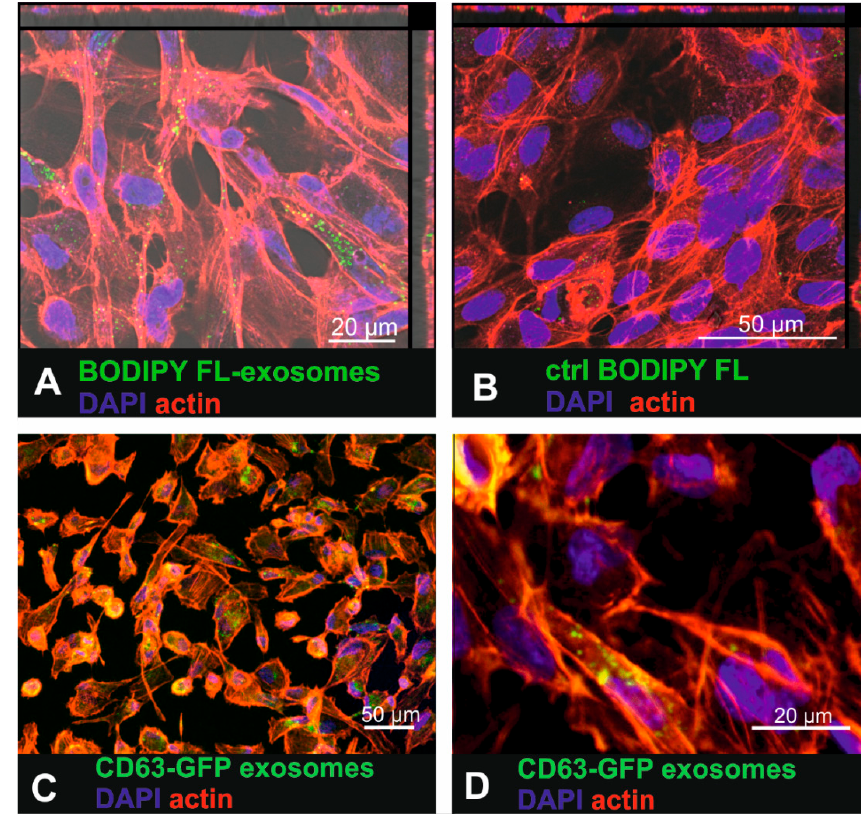
Figure 2. Uptake of urinary BODIPY-labelled small EVs and CD63-GFP tagged fibroblast-derived small EVs in ARPE19 cells. ( A ) Incubation of the ARPE-19 cells with BODIPY-labelled small EVs that were purified to remove unbound dye. ( B ) ARPE-19 cells exposed to purified (removal of small-sized vesicles) BODIPY solution (control (ctrl)) where no internalized fluorescence should be detected. ( C ) Uptake of fibroblast-derived CD63-GFP tagged small EVs in ARPE19 cells. ( D ) Higher magnification of Figure 2C showing intracellular CD63-GFP expression that visualized tagged internalized small